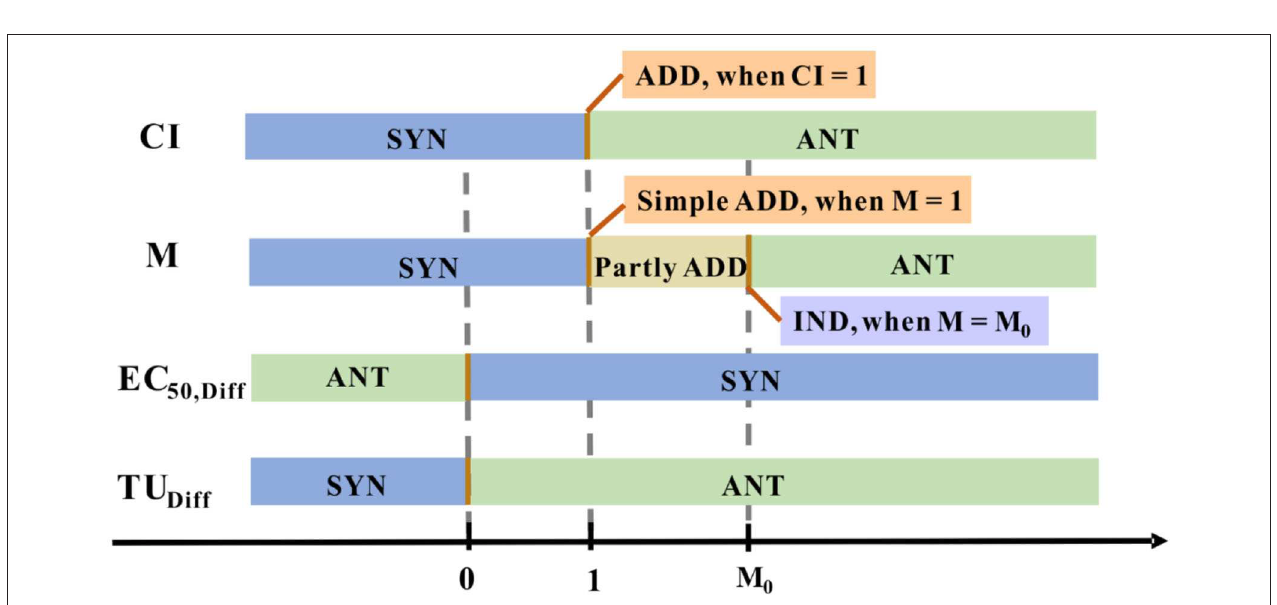
FIGURE 4 | Two examples of response surface modeling. (A) is the response surface for Cu 2 + - Pb 2 + mixture with a metal concentration in coded units (Ren et al., 2004 ). (B) is a color-coded (Loewe) additivity surface which compared with experimental combination data for the cytotoxic effect of etoposide–cisplatin combinations on NCI-H226 cell lines in ACL-4 medium ( Groten et al., 2001). Adapted and modified with permission from Ren et al. (2004) and Groten et al. (2001).